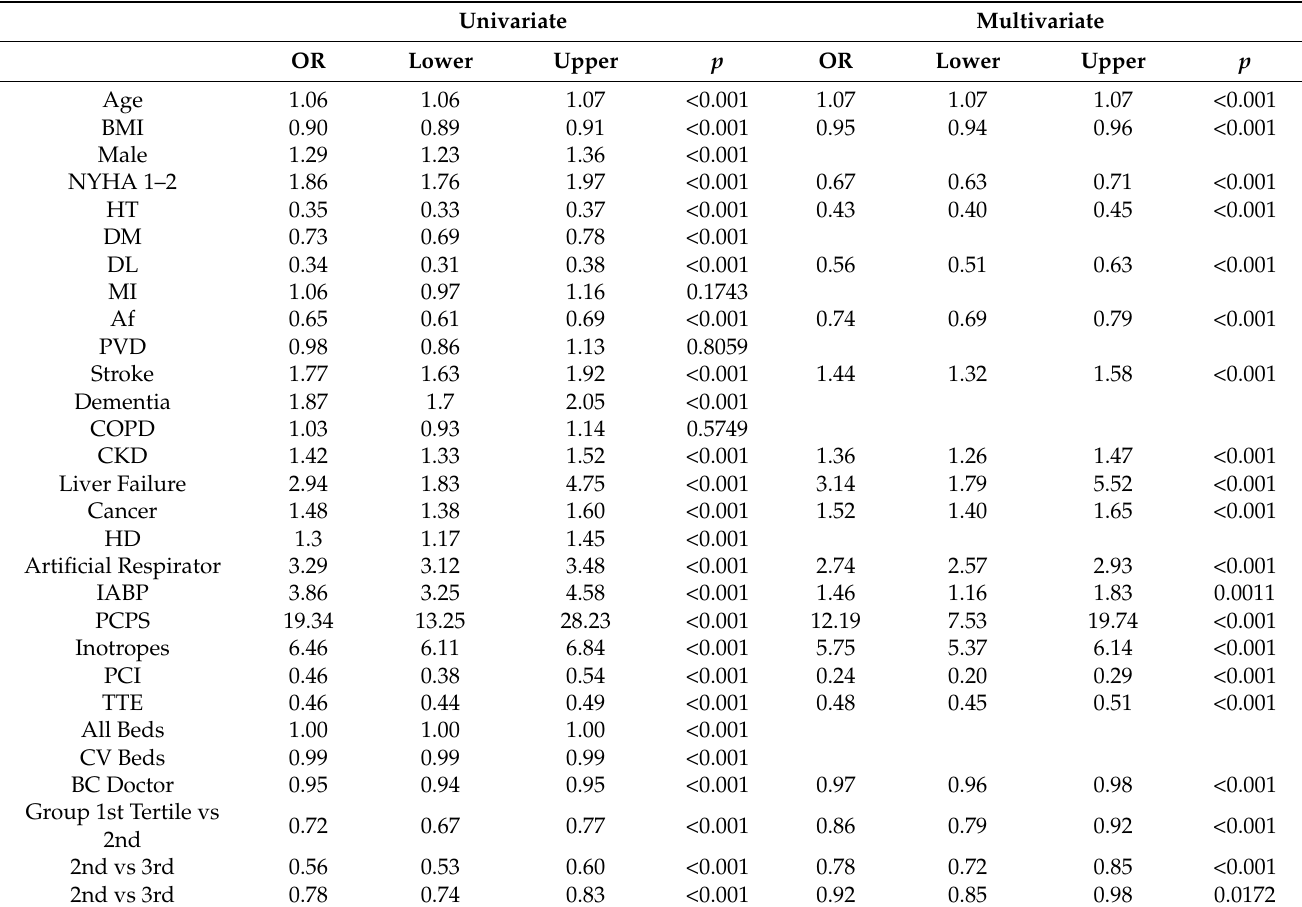
Table 3. Multivariate analysis of covariates for in-hospital mortality in all patients. Univariate Multivariate